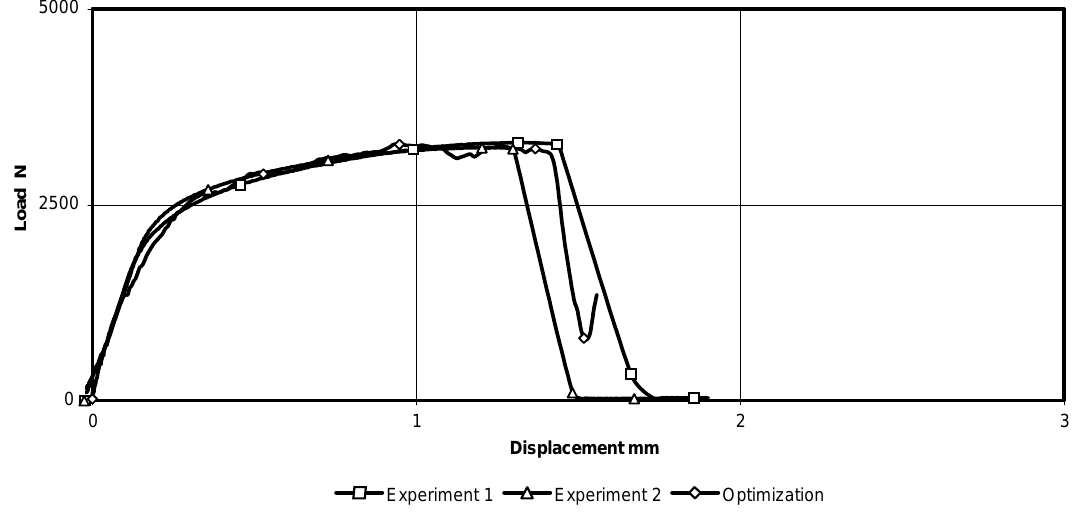
Fig. 13. Comparison of experimental and numerical results. (Single lap riveted joint shear specimens – 7050 aluminium